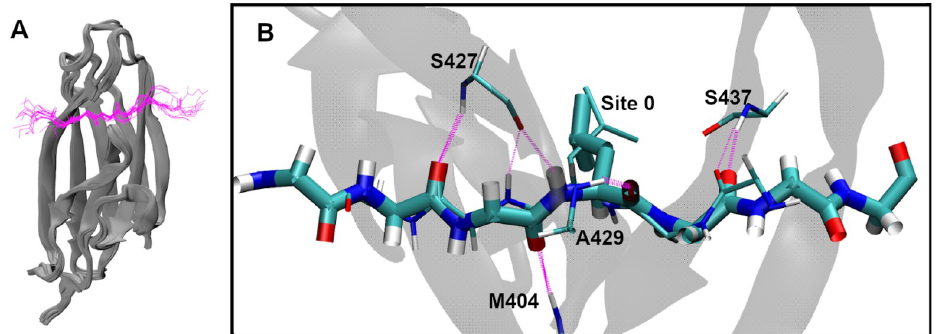
Fig 2. Conserved β SBD-substrate binding conformation. (A) Overlay of 18 bound substrate structures (S1 Table), aligned using the backbone atoms of the β SBD. The SBDs are show in gray cartoons, and the substrates in magenta backbone traces. Only the forward orientation substrates are included. (B) Overlay of two forward and reverse orientation peptide substrates (forward: NRLLLTG, PDB: 1DKZ [10]; reverse: NRLILTG, PDB: 4EZY [19]; underlines indicate residues at Site 0). The forward orientation is shown in thick bonds and the reverse in thin bonds. The backbone hydrogen bonds between β SBD and the substrate are shown in magenta dashed lines. Note that backbone hydrogen bonds involving M404, S427 and A429 completely overlap in two orientations. Side chains are shown only for the central L at Site 0. For more viewing angles of panel B, see S1 Movie.